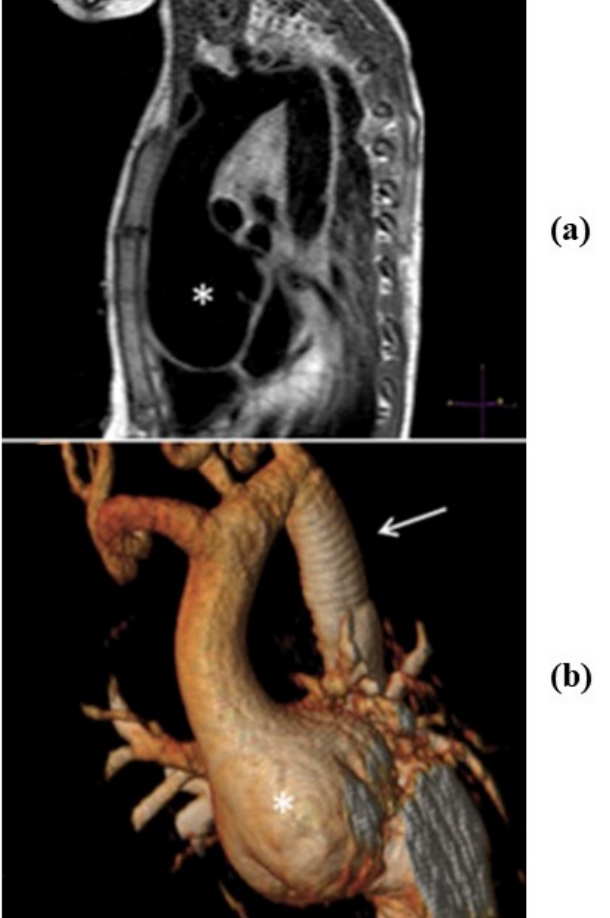
Figure 11. The aorta in Loeys-Dietz syndrome. Notice the large anuloaortic ectasia ( a , b ) by tomogra- phy. From Rizzo S et al. Ann Thorac Surg. 2016 Mar; 101(3):1193-5, with permission. Turner syndrome is characterized by the absence of one X chromosome in a